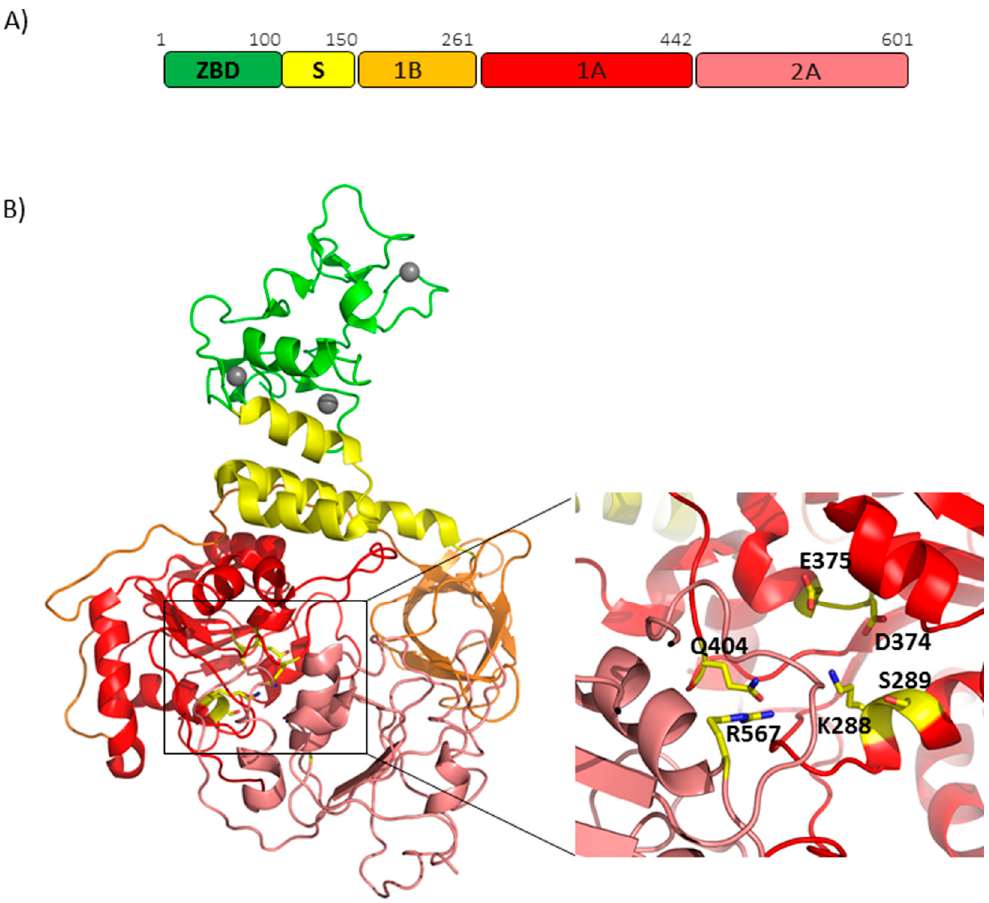
Figure 7. SARS-CoV-2 Nsp13 helicase. ( A ) Domain organization of SARS-CoV-2 Nsp13. ( B ) Cartoon representation of the homology model of SARS-CoV-2 Nsp13, obtained using MODELLER based on the crystallographic structure of the SARS-CoV (PDB code 6JYT, covered region 1-596). The colors of the protein domains are indicated in panel A (ZBD-green, stalk-yellow, 1B-orange, 1A-red and 2A-salmon). Three zinc atoms are shown as grey spheres. In the inset, the key conserved residues responsible for NTP hydrolysis are drawn as sticks.